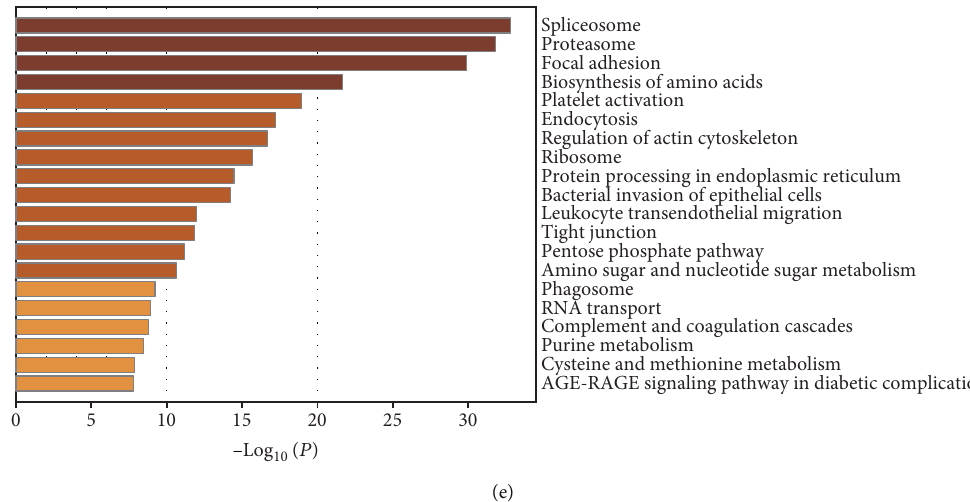
Figure 4: Bioinformatic analysis of the proteome of B cell exosomes. (a – c) Gene ontology annotation of the proteins identi fi ed in B cell exosomes based on (a) cellular component, (b) molecular function, and (c) biological process. (d) Pie chart showing Protein Analysis Through Evolutionary Relationships classi fi cation of the identi fi ed proteins from B cell exosomes. (e) The most enriched KEGG pathway of the proteome is visualized using